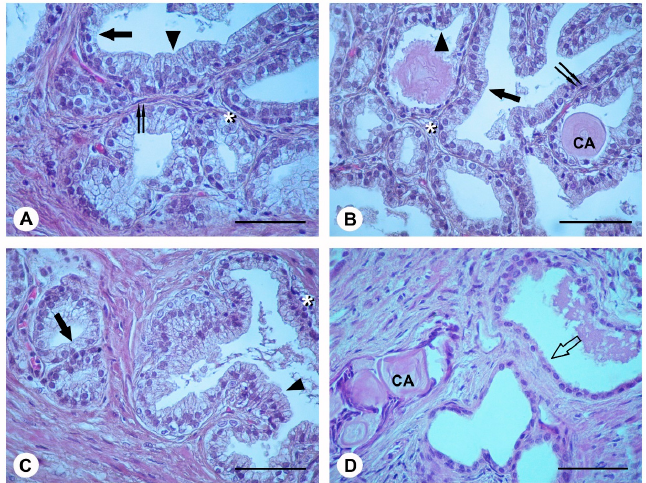
Figure 2. Histological patterns of the prostate from BPH patients at time 0; from BPH patients at 3 months; from Ser-Se-Ly treated BPH patients at time 0; and from Ser-Se-Ly treated BPH patients at 3 months; stained with hematoxylin and eosin (H&E). ( A – C ) In BPH patients at time 0 ( A ), in